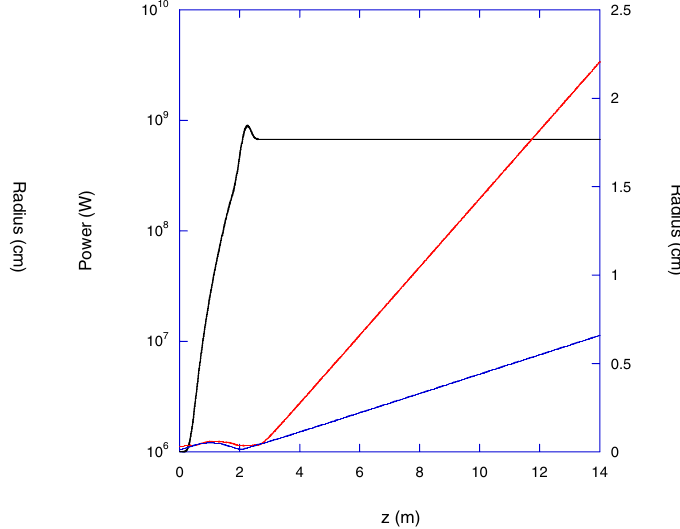
FIG. 6. (Color) Power (black), optical beam radius (red), and electron beam radius (blue) (green) over a large distance for a scalloped-beam FEL with a uniform wiggler.